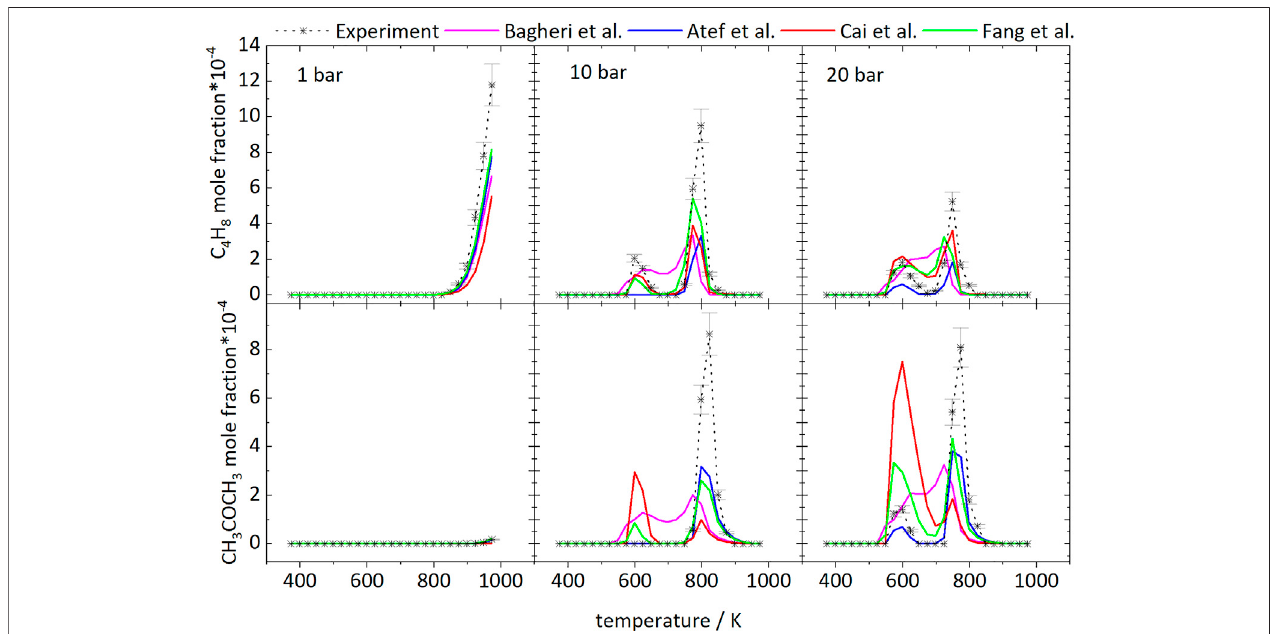
FIGURE 14 | Mole fractions of iso-butene and acetone vs. reactor-temperature at 1, 10, and 20 bar. Dashed lines with symbols and solid lines illustrates the experimental and modeled results, respectively.